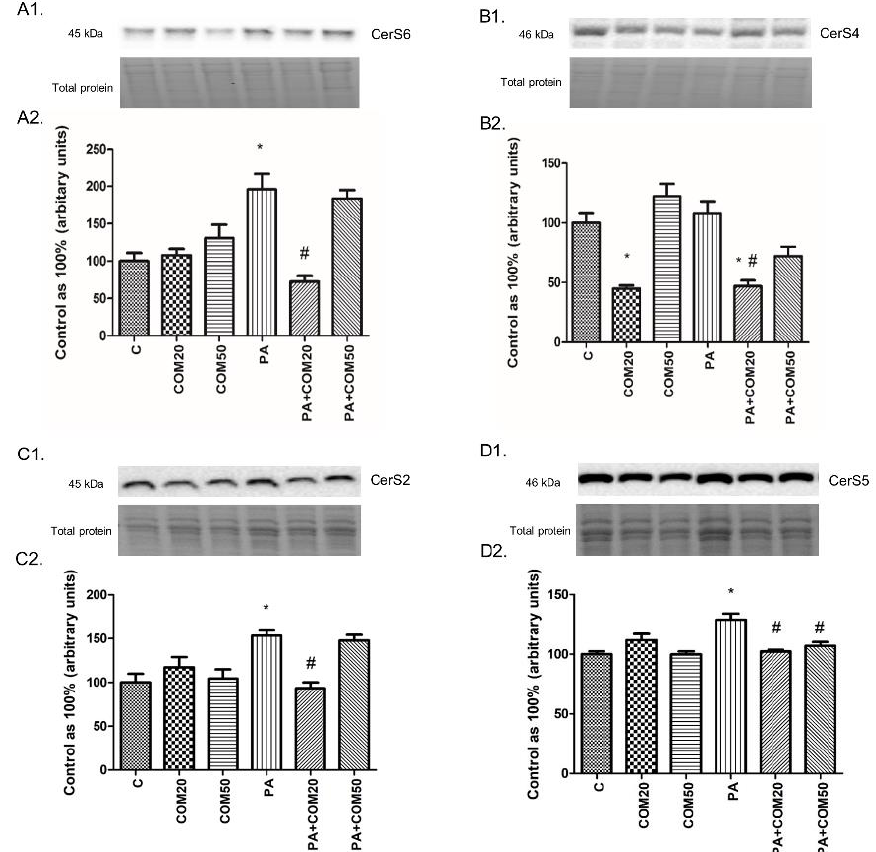
Figure 4. Representative Western Blot membranes of evaluated proteins, i.e., CerS6—ceramide synthase 6 ( A1 ), CerS4—ceramide synthase 4 ( B1 ), CerS2– ceramide synthase 2 ( C1 ), CerS5– ceramide synthase 5 ( D1 ), and the corresponding images of total protein staining after membrane transfer used for normalization. The expression of enzymes involved in both ceramide de novo synthesis and salvage pathways, i.e., CerS6 ( A2 ), CerS4 ( B2 ) CerS2 ( C2 ), and CerS5 ( D2 ) in primary rat hepatocytes. The cells were incubated with presence or absence of PA (0.5 mM) or/and COM (20 or 50 µ M), as it was described in Materials and Methods section. The protein expression was evaluated by the Western blot technique. The data are shown as the mean ± SD and are based on six independent determinations ( n = 6); * p < 0.05 significant difference vs. control group; # p < 0.05 significant difference vs. palmitate group; C, control; COM20 or COM50, coumestrol 20 or 50 µ M; PA, palmitic acid; PA + COM20 or PA + COM50, palmitic acid + coumestrol 20 or 50 µ M. 3.6. Effects of Coumestrol on the Expression of Proteins Involved in Fatty Acid Uptake and β -Oxidation in Primary Rat